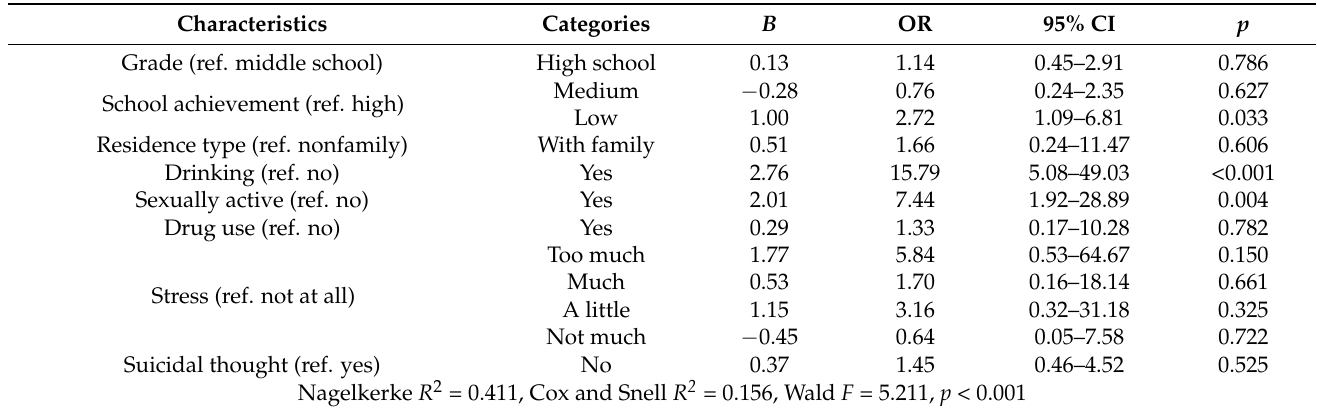
Table 2. Factors influencing smoking among multicultural adolescents ( N =